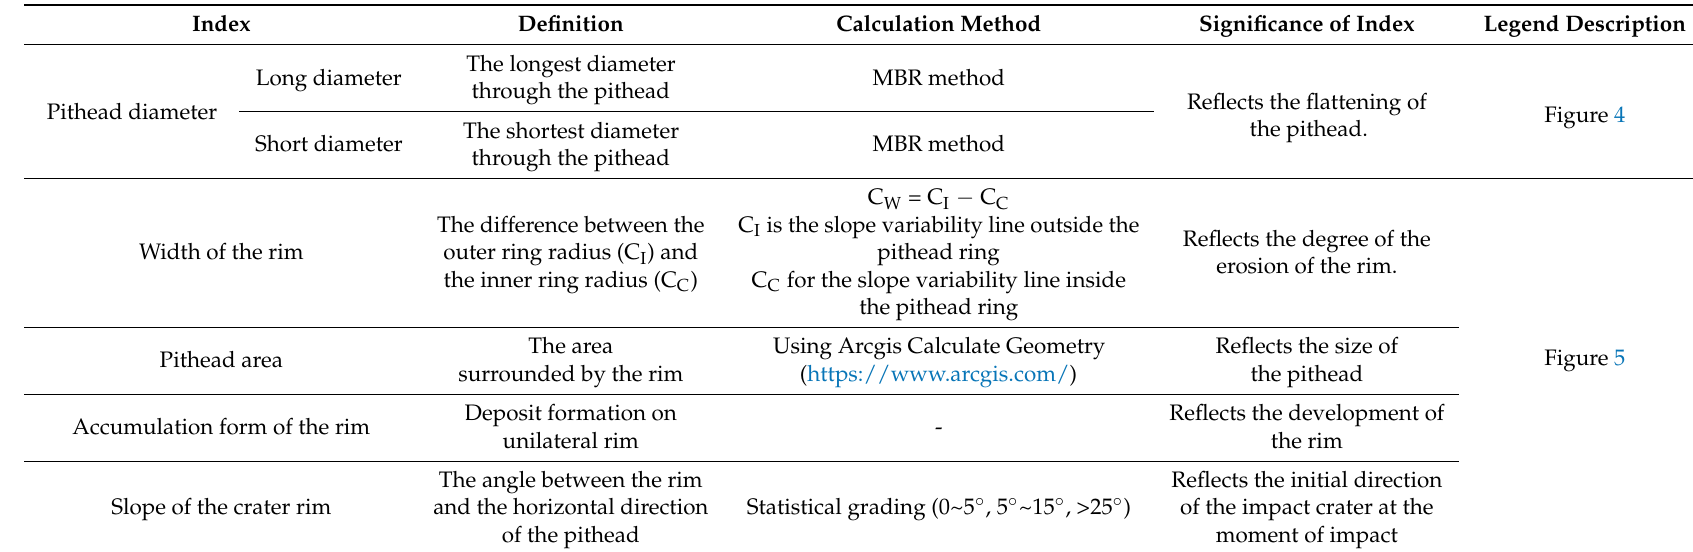
Table 2. Indices for description of the crater